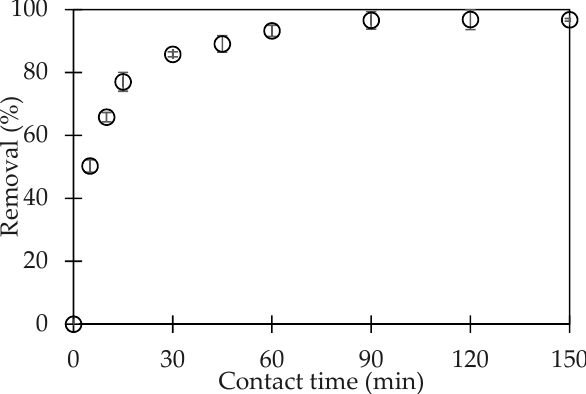
Figure 5. Effect of contact time on CFX-removal by using PSS-modified alumina (PMA). (Ci (CFX) = 10 mg/L, adsorbent dosage 5 mg/mL, pH 6, 1-mM NaCl). Error bars show standard deviation of three replicates.